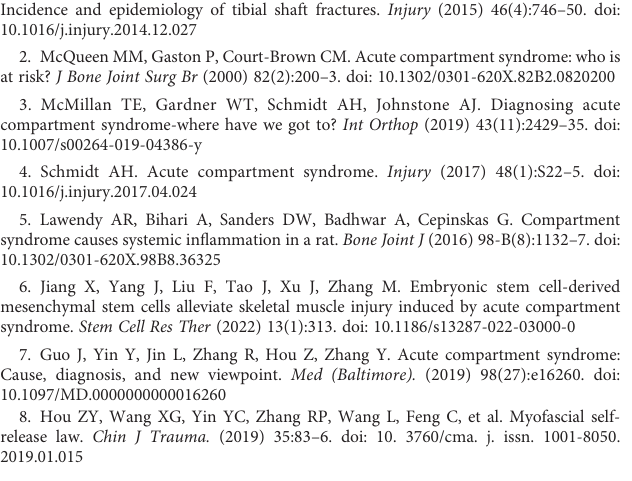
SUPPLEMENTARY FIGURE 1 Gene Ontology (GO) terms of T cell subtypes. (TCM=central memory T cell; Teff=effector T cell; Treg=regulator T cell; ILC=innate lymphoid cells; NKT=nature killer T cell) SUPPLEMENTARY FIGURE 2 Kyoto Encyclopedia of Genes and Genomes (KEGG) pathways of T cell subtypes. (TCM=central memory T cell; Teff=effector T cell; Treg=regulator T cell; ILC=innate lymphoid cells; NKT=nature killer T cell) SUPPLEMENTARY FIGURE 3 Gene Ontology (GO) terms of macrophage (Mac) subtypes. SUPPLEMENTARY FIGURE 4 Kyoto Encyclopedia of Genes and Genomes (KEGG) pathways of macrophage (Mac) subtypes. SUPPLEMENTARY FIGURE 5 Gene Ontology (GO) terms of dendritic cells (DCs) subtypes. SUPPLEMENTARY FIGURE 6 Kyoto Encyclopedia of Genes and Genomes (KEGG) pathways of dendritic cells (DCs) subtypes. SUPPLEMENTARY FIGURE 7 Gene Ontology (GO) terms and Kyoto Encyclopedia of Genes and Genomes (KEGG) pathways of monocyte (Mon) subtypes. (A) GO terms of Mon subtypes. (B) KEGG pathways of Mon subtypes. SUPPLEMENTARY FIGURE 8 Gene Ontology (GO) terms of fi broblast (Fib) subtypes. SUPPLEMENTARY FIGURE 9 Kyoto Encyclopedia of Genes and Genomes (KEGG) pathways of fi broblast (Fib)